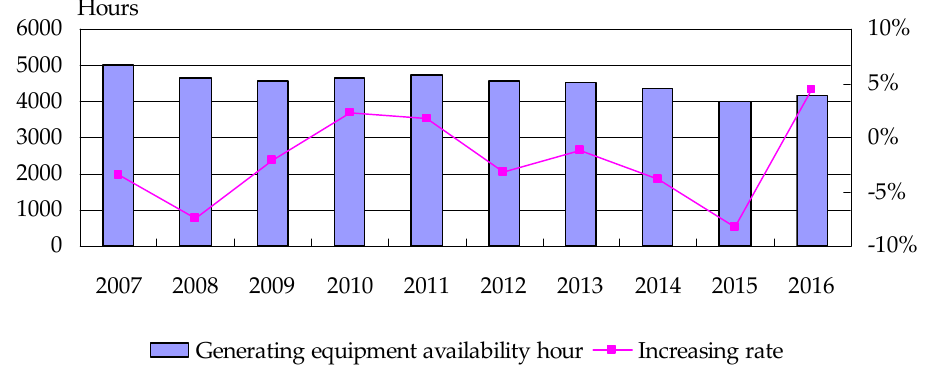
Figure 4. Generating equipment availability hours and increasing rate of thermal power from 2007 to 2016 in China.